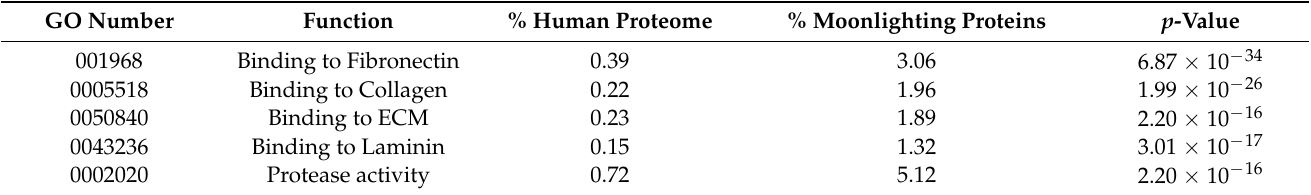
Table 2. Some of the GO codes shared between metastasis and virulence-related moonlighting proteins. The abundances compared to the human proteome and human moonlighting proteins are shown in each